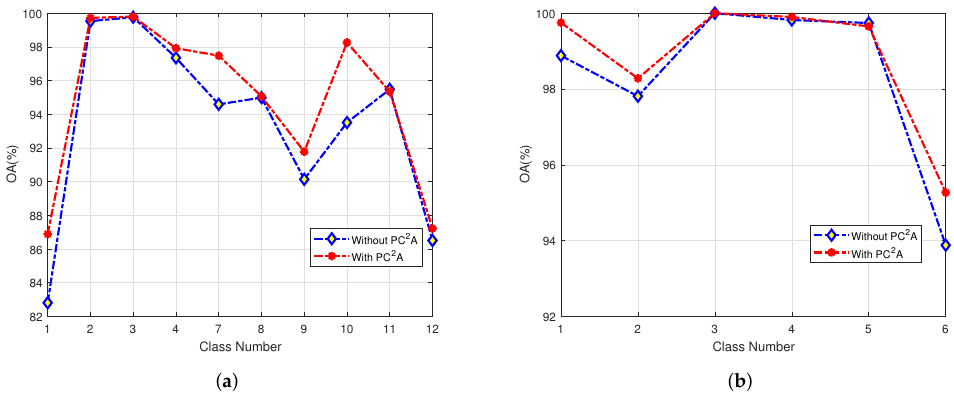
Figure 11. Influence of with/without PC 2 A module on classification accuracies of each class. ( a ) 2012 Houston data set. ( b ) Trento data